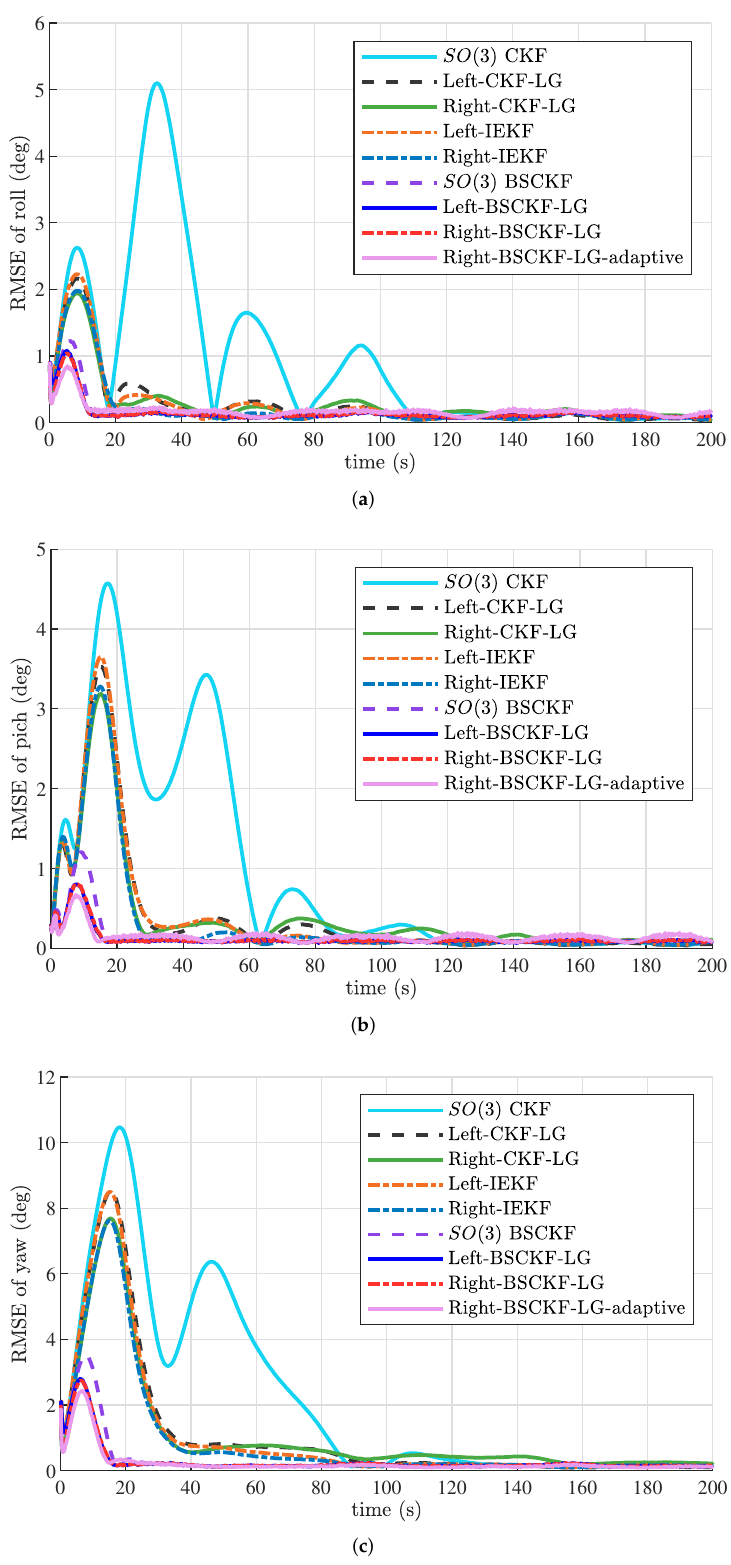
Figure 3. RMSEs of Euler angles in Case 1. ( a ) RMSEs of roll angle; ( b ) RMSEs of pitch angle; ( c ) RMSEs of yaw